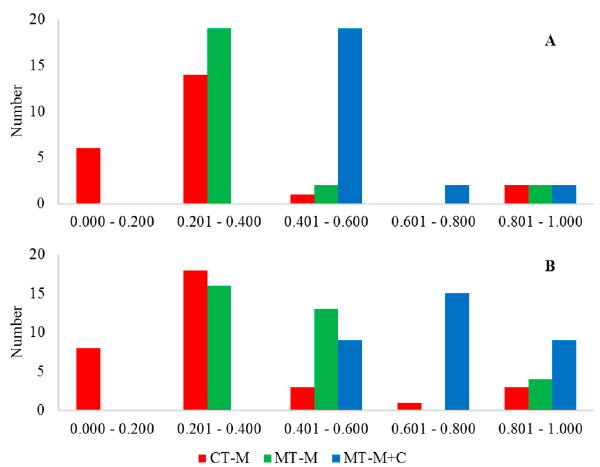
Figure 2. Frequency distribution of VRS technical efficiencies for Rudhiapada ( A ) and Badamahulidiha ( B ) in Odisha, India for different cropping systems. CT = conventional tillage, MT = = reduced tillage.